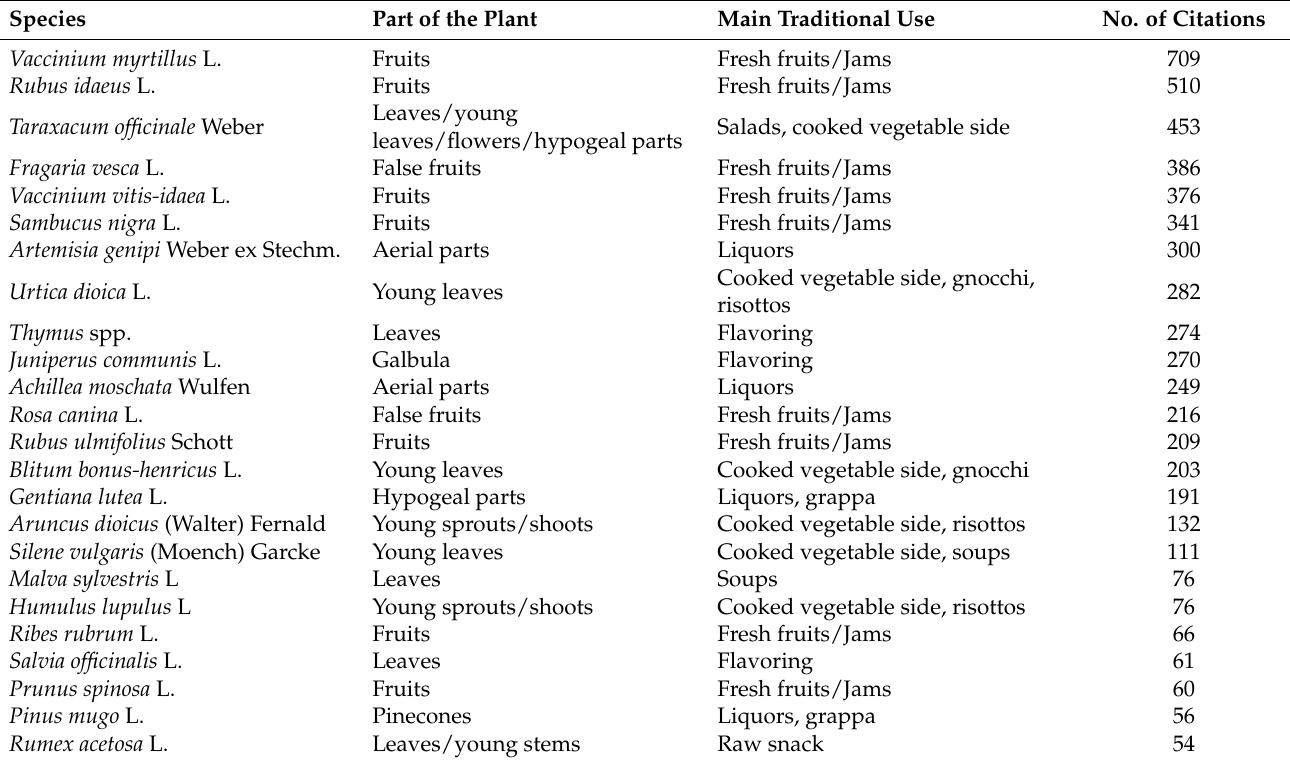
Table 3. Plant species mentioned in Valmalenco at least 50 times in the food sector, considering only current and first-person